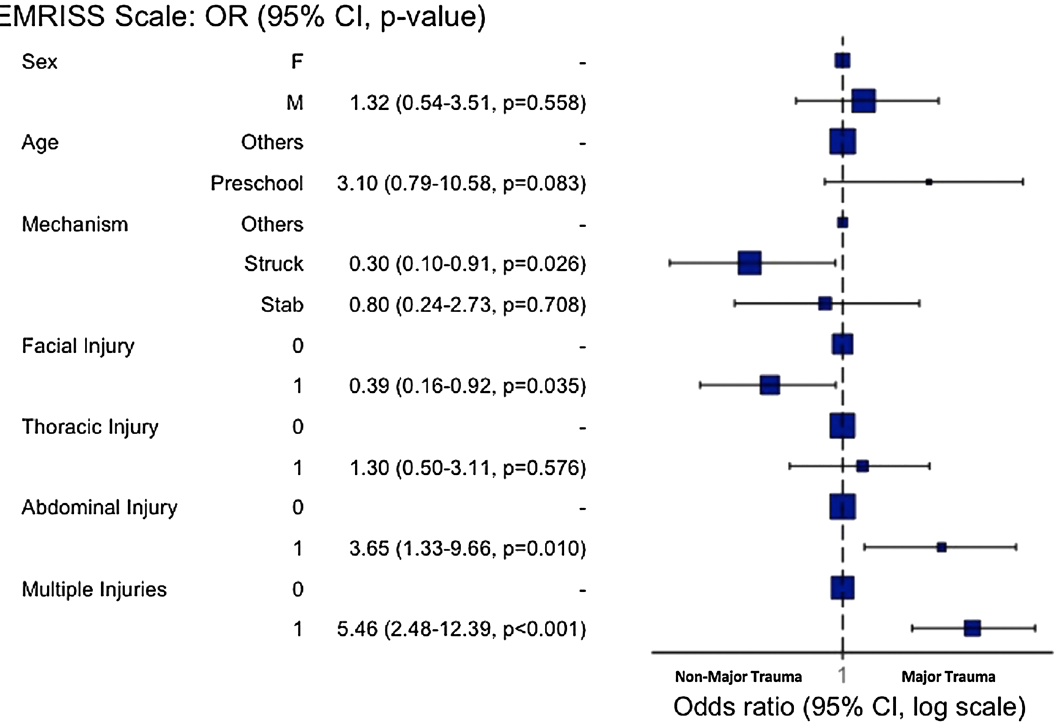
Figure 3. Multivariable regression analysis and adjusted odds ratio of risk factors for non-major trauma versus major trauma. CI confidence interval, EMR-ISS excess mortality ratio-adjusted injury severity, OR odds ratio, 1 present, 0